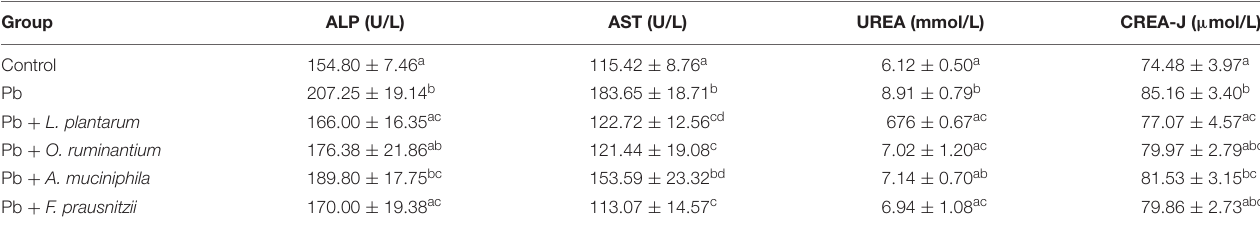
TABLE 4 | The effects of Pb-intolerant gut microbes on the values of haematogenic immunity parameters in chronically Pb- exposed mice. Group